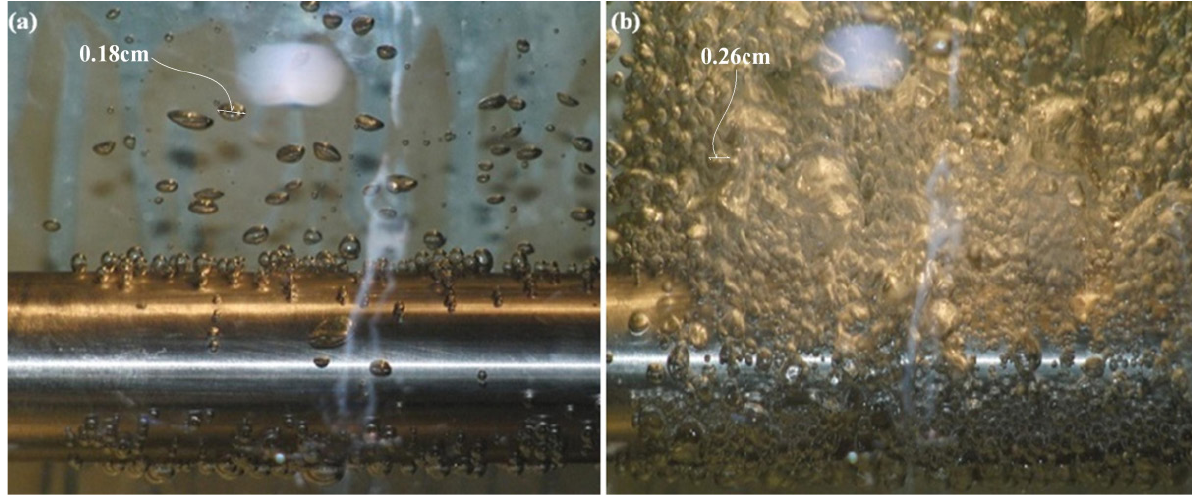
Figure 5: A view of bubble growth in two-component water-ethanol solution at a) low and b) high heat fluxes.